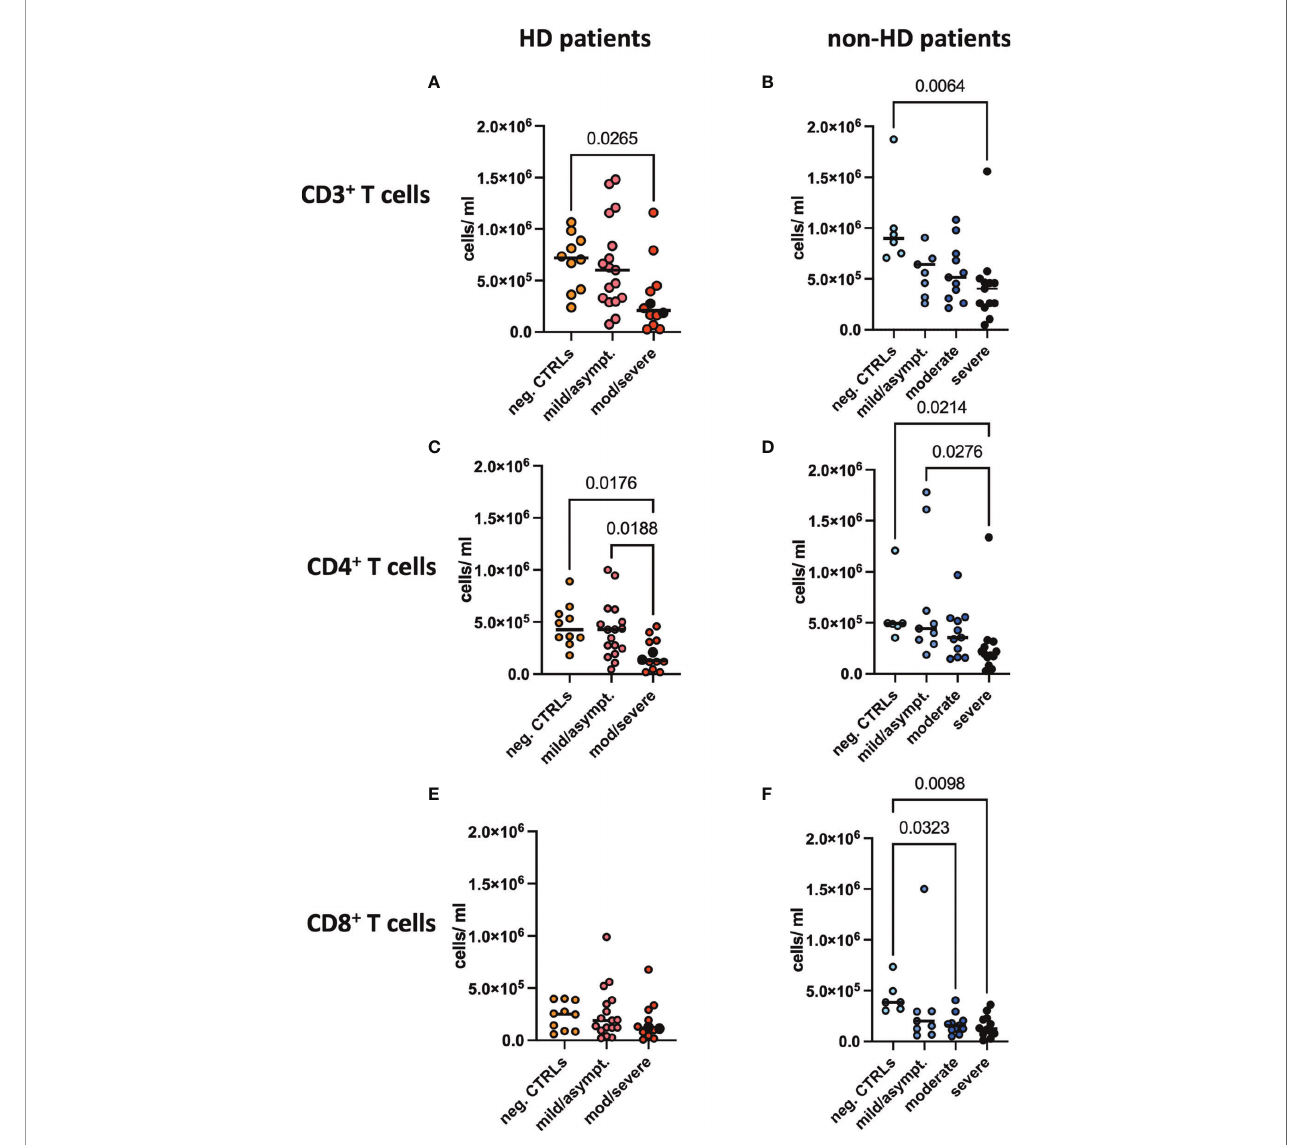
FIGURE 2 | Absolute T cellnumbersin peripheral blood. Absolute numbersof (A,B) CD3 + , (C,D) CD4 + and (E, F) CD8 + T cells were evaluated inthe peripheral blood of (A,C,E) HD- and (B, D,F) non-HD patients withoutSARS-CoV-2 infection (orange circles, HD: n = 10; light blue circles, non-HD:6), with mild/asymptomatic(light red circles, HD: n = 18; mid blue circles, non-HD:n = 9),moderate (red circles, HD:n = 11; blue circles, non-HD:n = 11)and severe COVID-19 disease (black circles, HD: n = 2; darkblue circles, non-HD:n = 13). Severe and moderate COVID-19 HD patients were analyzed as one group. Data are shown as individual values as wellas